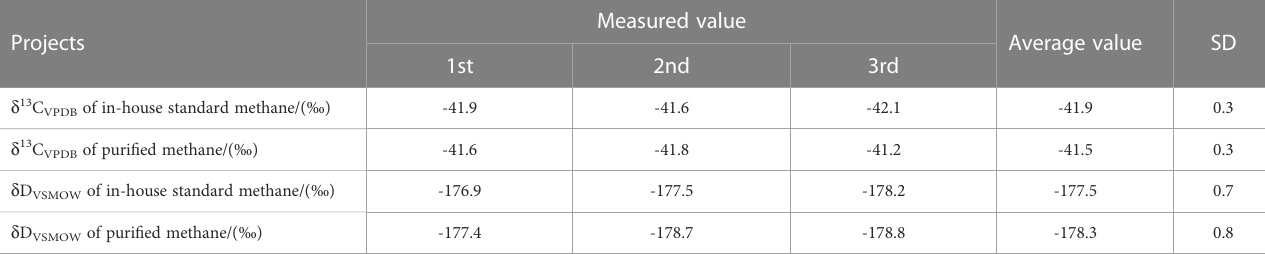
TABLE 8 Comparison of internal and external precision of in-house standards with other Ultra HR-IRMS laboratories. Internal precision (1